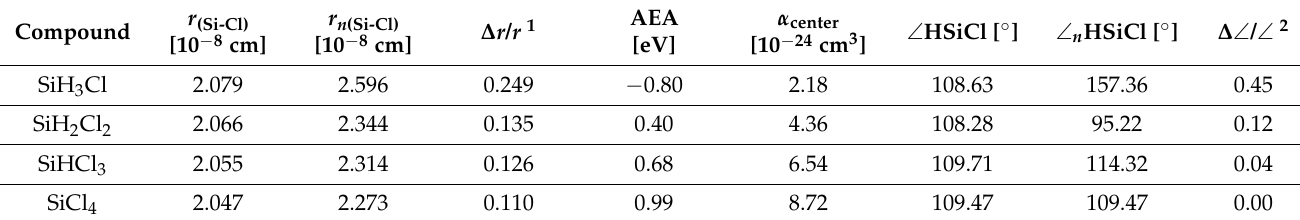
Table 2. Relative changes in the bond length for a negative ion and its neutral, ∆ r/r , adiabatic electron affinity, AEA, and relative changes in the H-Si-Cl bond angle for a negative ion and its neutral state, ∆ ∠ / ∠ . Calculated using the DFT/B3LYP for chlorine-substituted silanes.